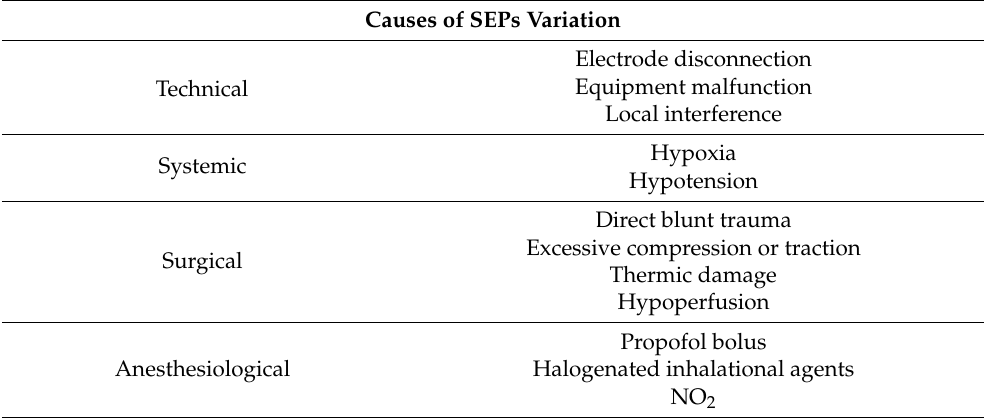
Table 2. Possible causes of SEPs